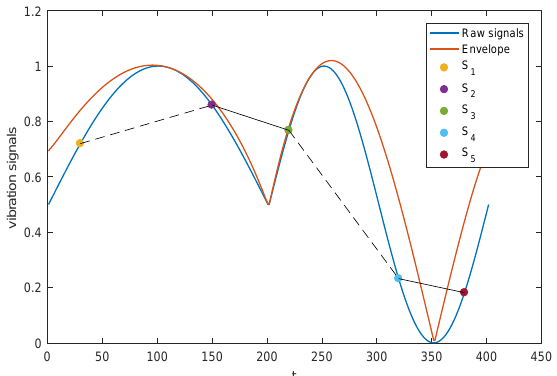
Figure 2. Relationship between the signal envelope and the visibility graph.